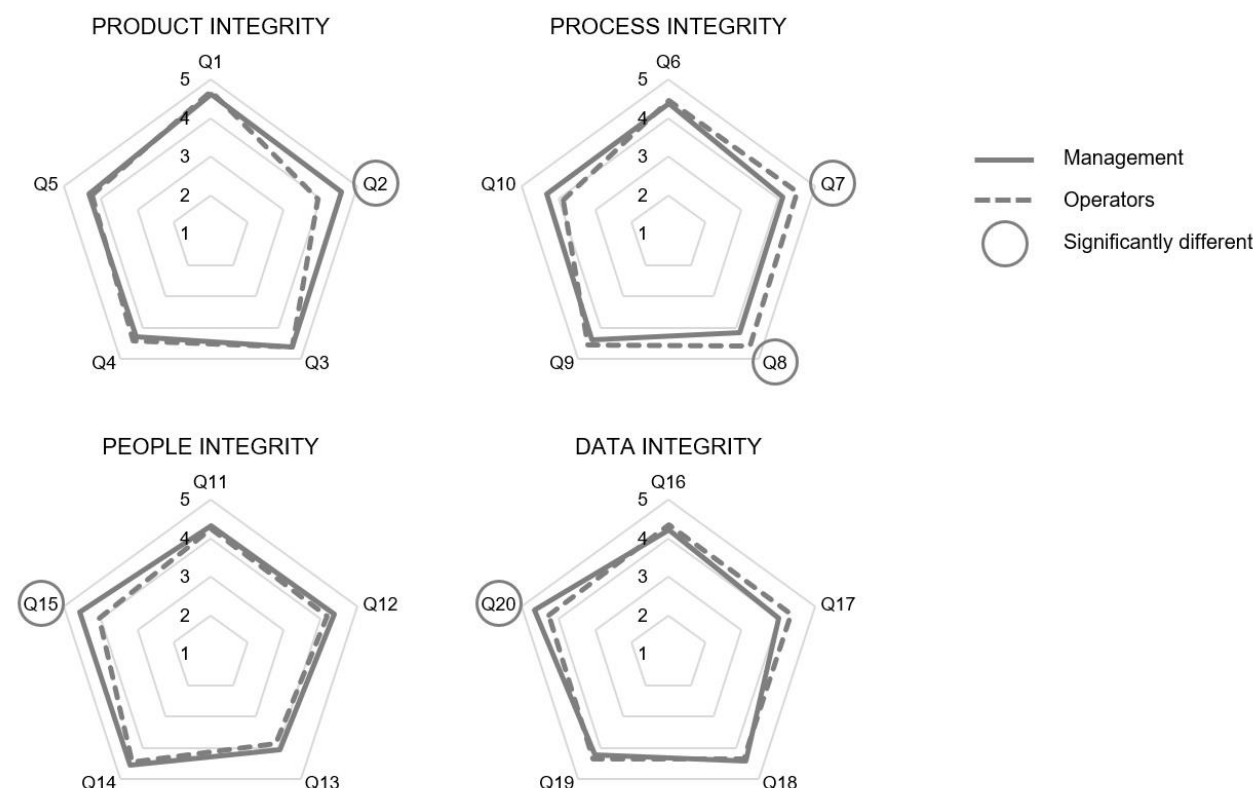
Figure 3. Radar chart with mean results of management ( n = 18) and operators ( n = 34) of the participating large-scale meat distribution company on the indicators of the food integrity elements. A five-point Likert answer scale (1 → 5: strongly disagree → strongly agree) was used. The indicators that showed a statistically significant difference between management and operators’ scores are circled ( p < 0.05). (See mean scores and p -values in Table A1 in Appendix B).